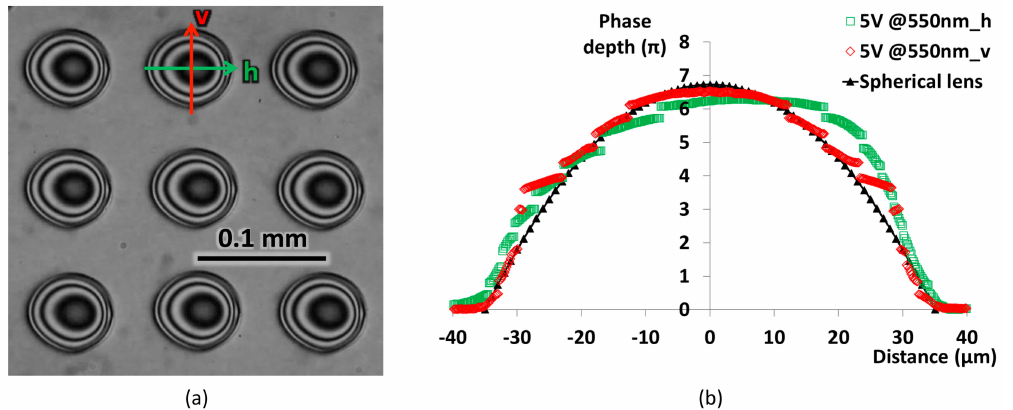
Figure 4. ( a ) Intensity variations of the LCML array under the microscope when a 5 V rms voltage signal is applied and ( b ) converted phase depth variation across the horizontal and vertical axis of one